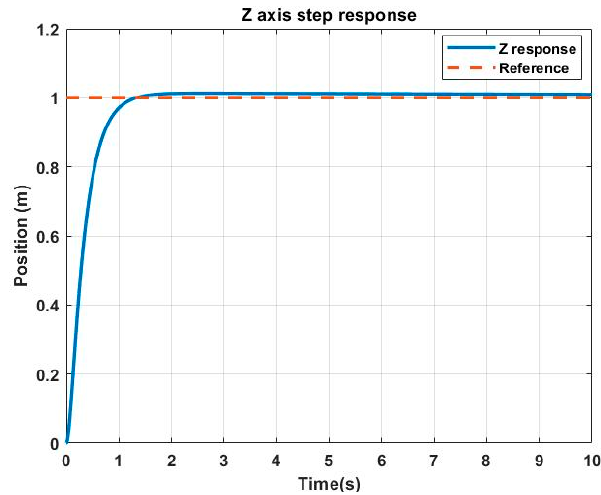
Figure 22. PID step response in Y axis.